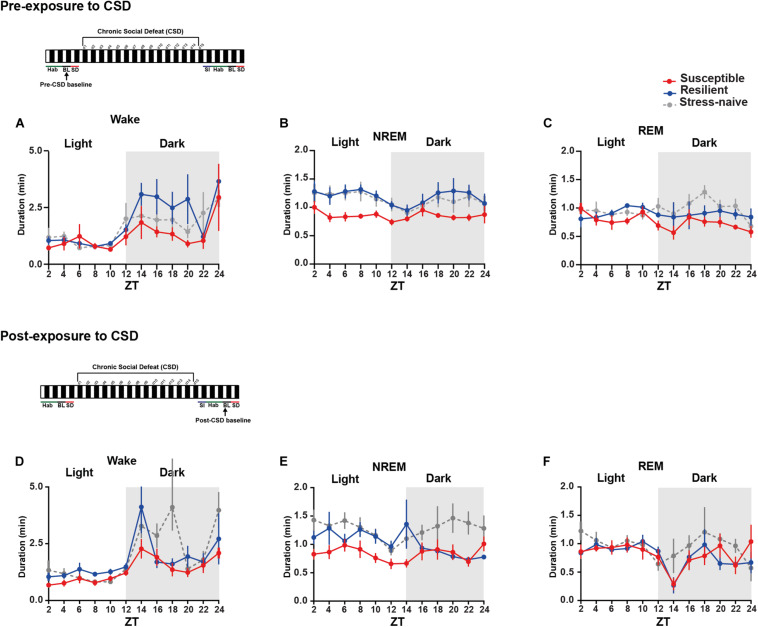
Mice susceptible to stress exhibited shorter average duration of NREM bouts pre-and post-CSD stress in the light. (A–C)
Pre-CSD stress:
(B) The average duration of NREM bouts was shorter in the susceptible mice relative to resilient and stress-naïve mice (F2,19 = 3.278, p = 0.06). (D–F)
Post-CSD stress:
(E) The average duration of NREM bouts of susceptible mice was shorter than the average NREM bout duration of resilient and stress-naïve mice in the light (F2,19 = 5.05, p < 0.05). In the dark, an effect of “phenotype” (F2,15 = 4.082, p < 0.05), when excluding the first 2-h, was due to the fact that the average duration of NREM bouts of susceptible mice was shorter relative to stress-naïve mice only. Values are expressed as average bout duration (mean ± sem) across 2-h intervals. n = 7–8 for each group.